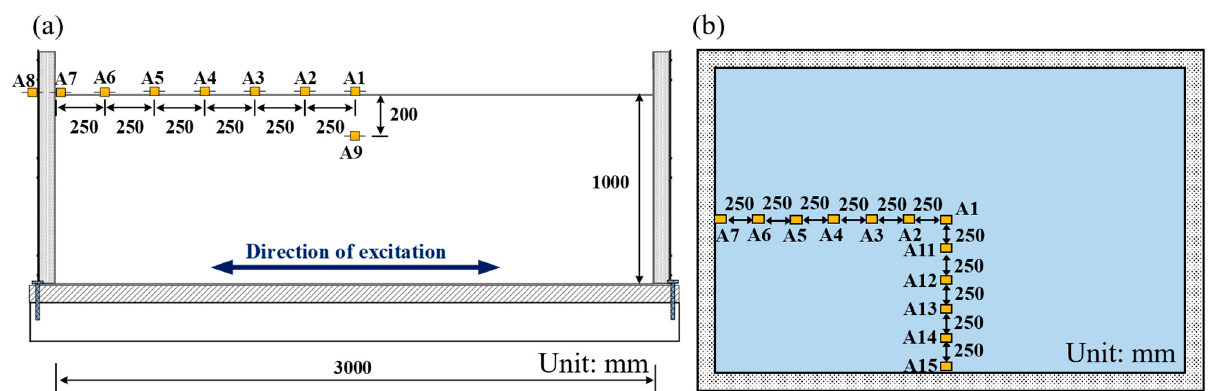
Figure 12. Layout of the free-field vibration table test sensor: ( a ) Schematic of the layout of the sensor: elevation, ( b ) Schematic diagram of the layout of the sensor: plane.